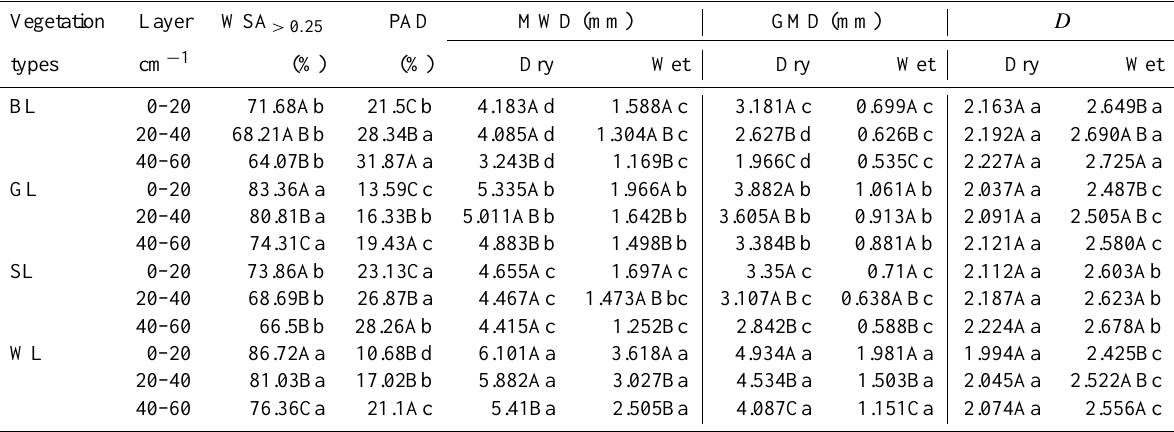
Table 3. The soil aggregate stability based on dry–wet sieving method. Vegetation Layer WSA > 0 . 25 PAD MWD (mm) GMD (mm)